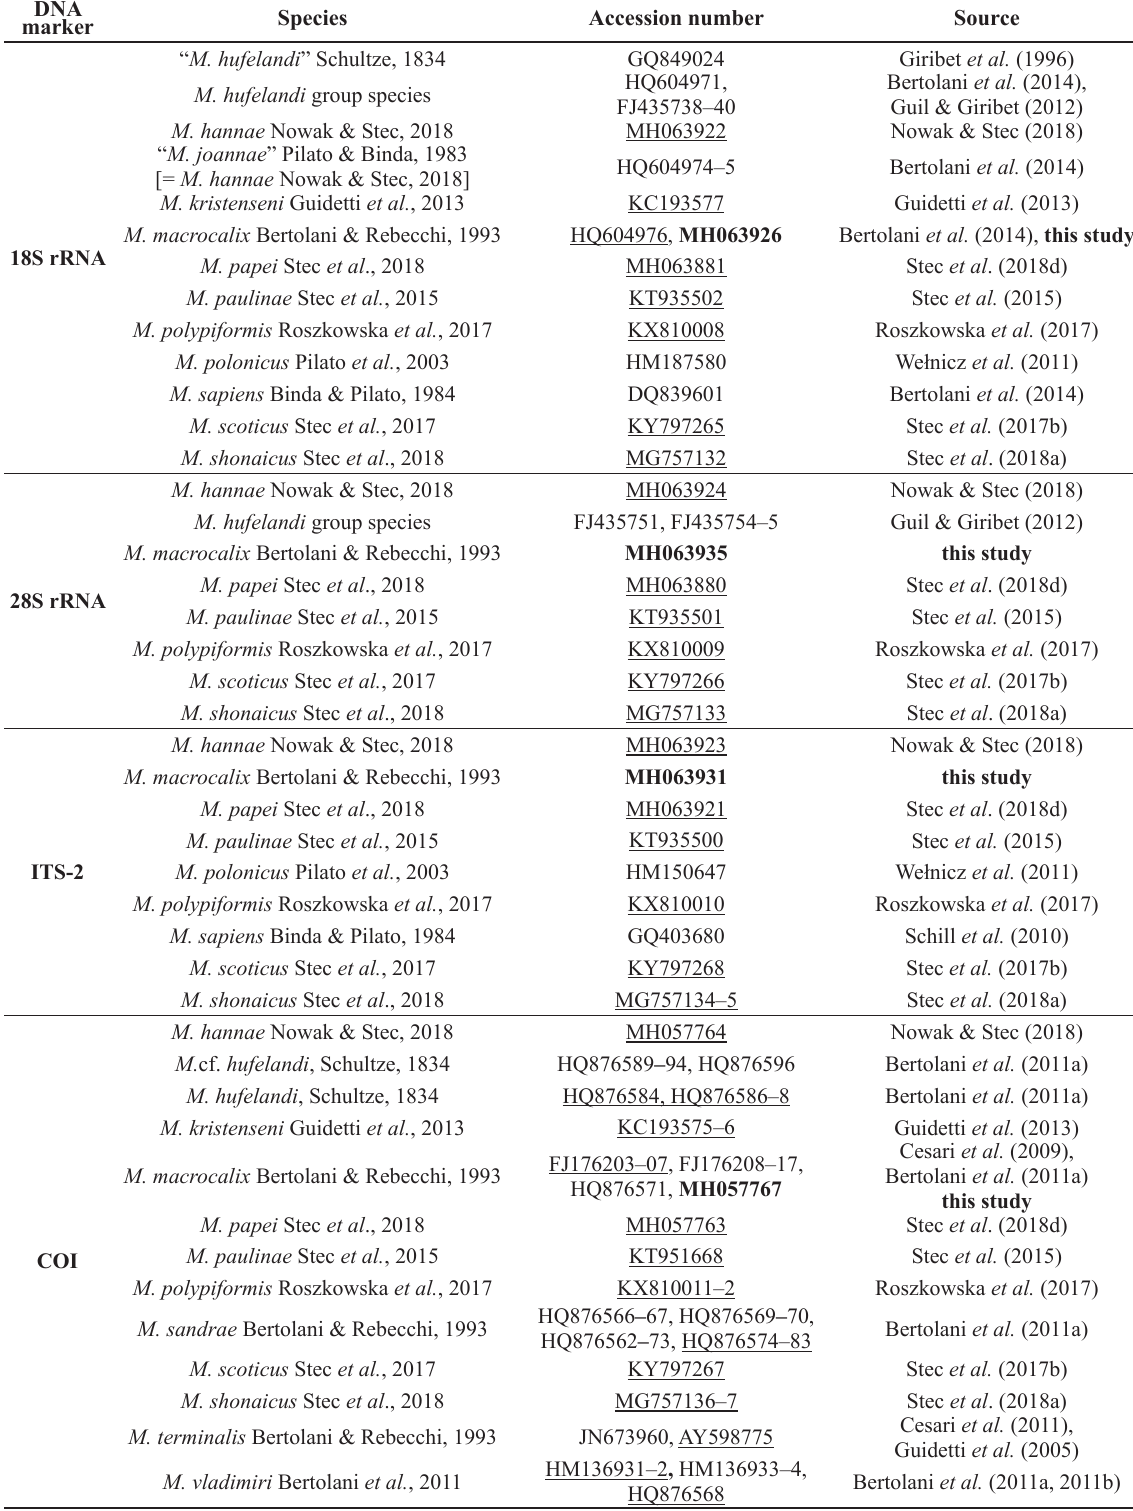
Table 3. Sequences of species of the Macrobiotus hufelandi group used for molecular comparisons and the phylogenetic analyses of Macrobiotus canaricus sp. nov. and M. cf. recens Cuénot, 1932. Underlined GenBank accession numbers indicate type or neotype sequences, whereas bolded numbers indicate new sequences obtained in this